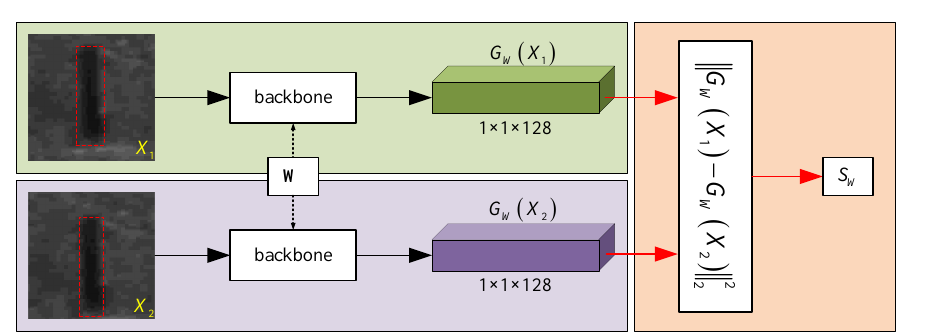
Figure 6. The architecture of SiamNet. SiamNet consists of the backbone and the cost module cascade. The green area and the pink area show the same backbone as the shared parameter W . The orange area shows the cost module. The value of S W denotes the similarity between X 1 and X 2 . The similarity is positively correlated with S W